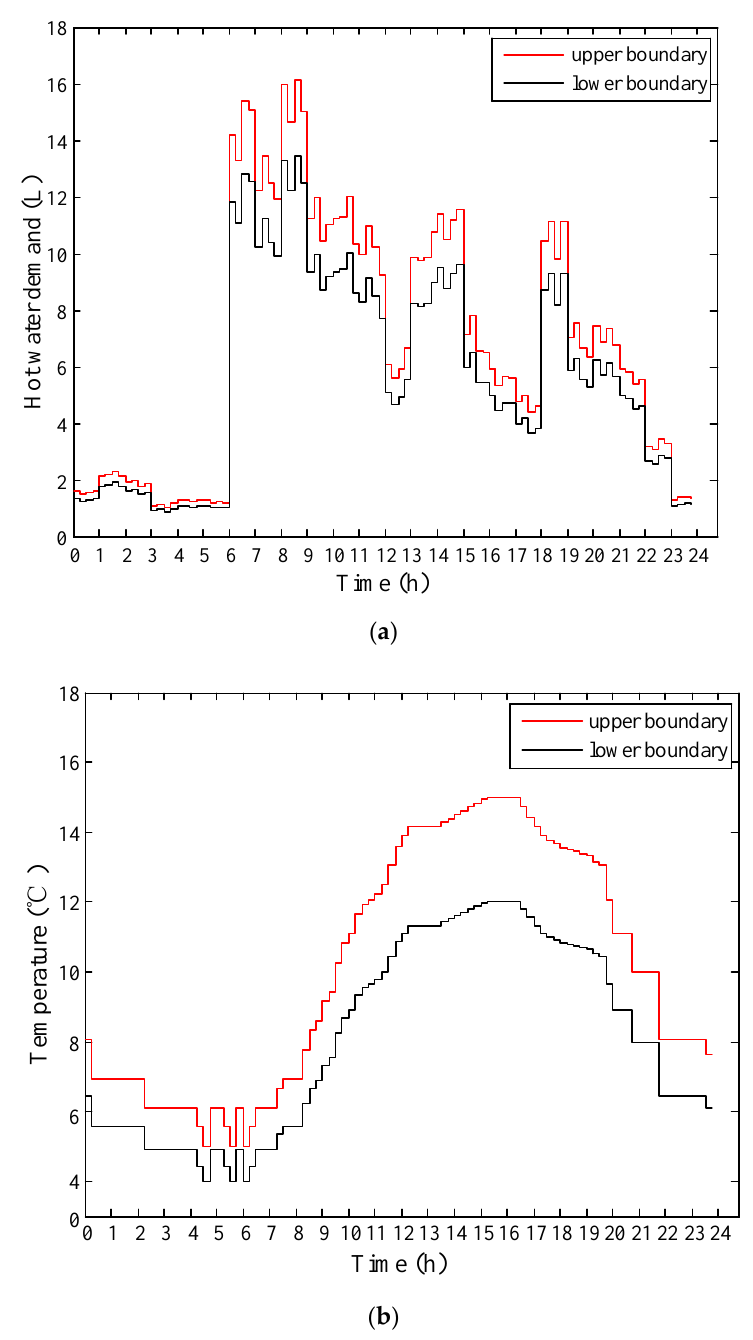
Figure 3. Maximum forecast intervals for the next day. ( a ) Hot water demand; ( b ) Ambient temperature.